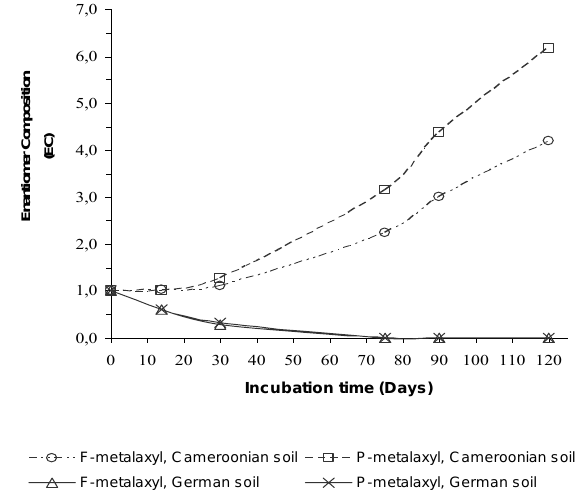
Figure 4: Profiles of the enantiomeric composition of F- metalaxyl and P- metalaxyl in